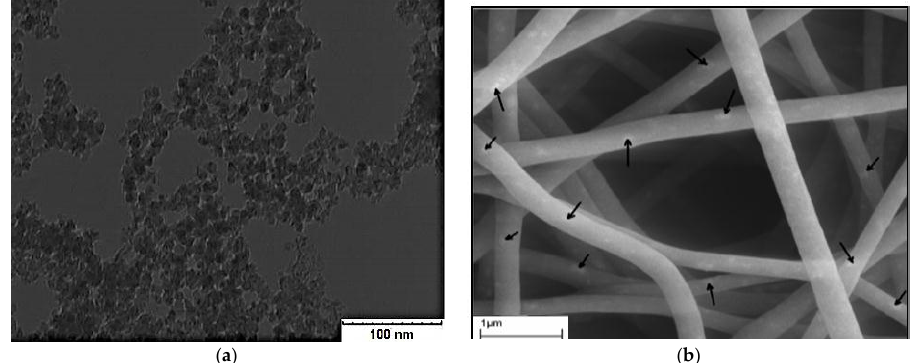
Figure 3. ( a ) TEM of ceria NPs and ( b ) SEM of nanofibers with embedded ceria with the arrows showing the agglomerated parts of ceria NPs over the PVA nanofibers.